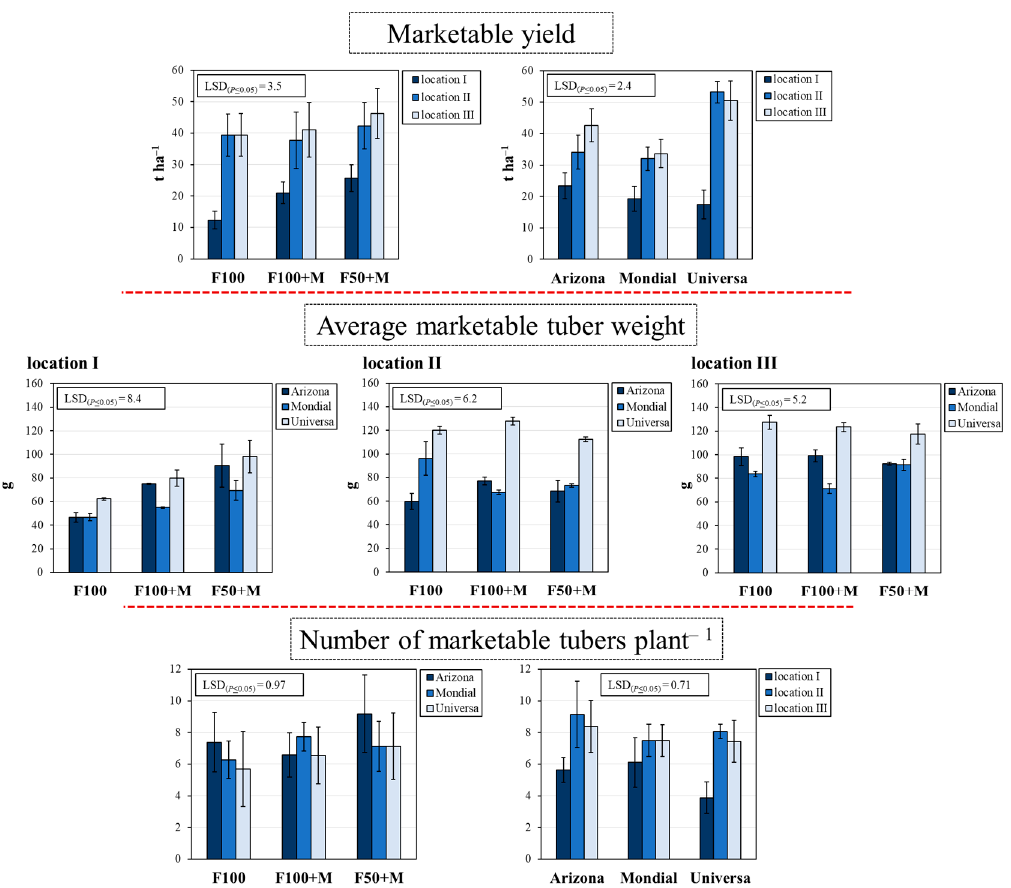
Figure 3. Marketable yield (t ha –1 ), average marketable tuber weight (g) and number of marketable tubers plant − 1 of early crop potato organically grown in highly calcareous soils as affected by fertilization management, soil type and potato cultivar. The Least Significant Difference (LSD) interaction was calculated with the Fisher’s protected LSD test at α = 0.05. Each bar means ± standard deviation ( n = 3). F100: optimal fertilization without mycorrhizal inoculation (control); F100+M: optimal fertilization with mycorrhizal inoculation; F50+M: sub-optimal fertilization with mycorrhizal inoculation; ‘Arizona’, ‘Mondial’ and ‘Universa’: potato cultivars.